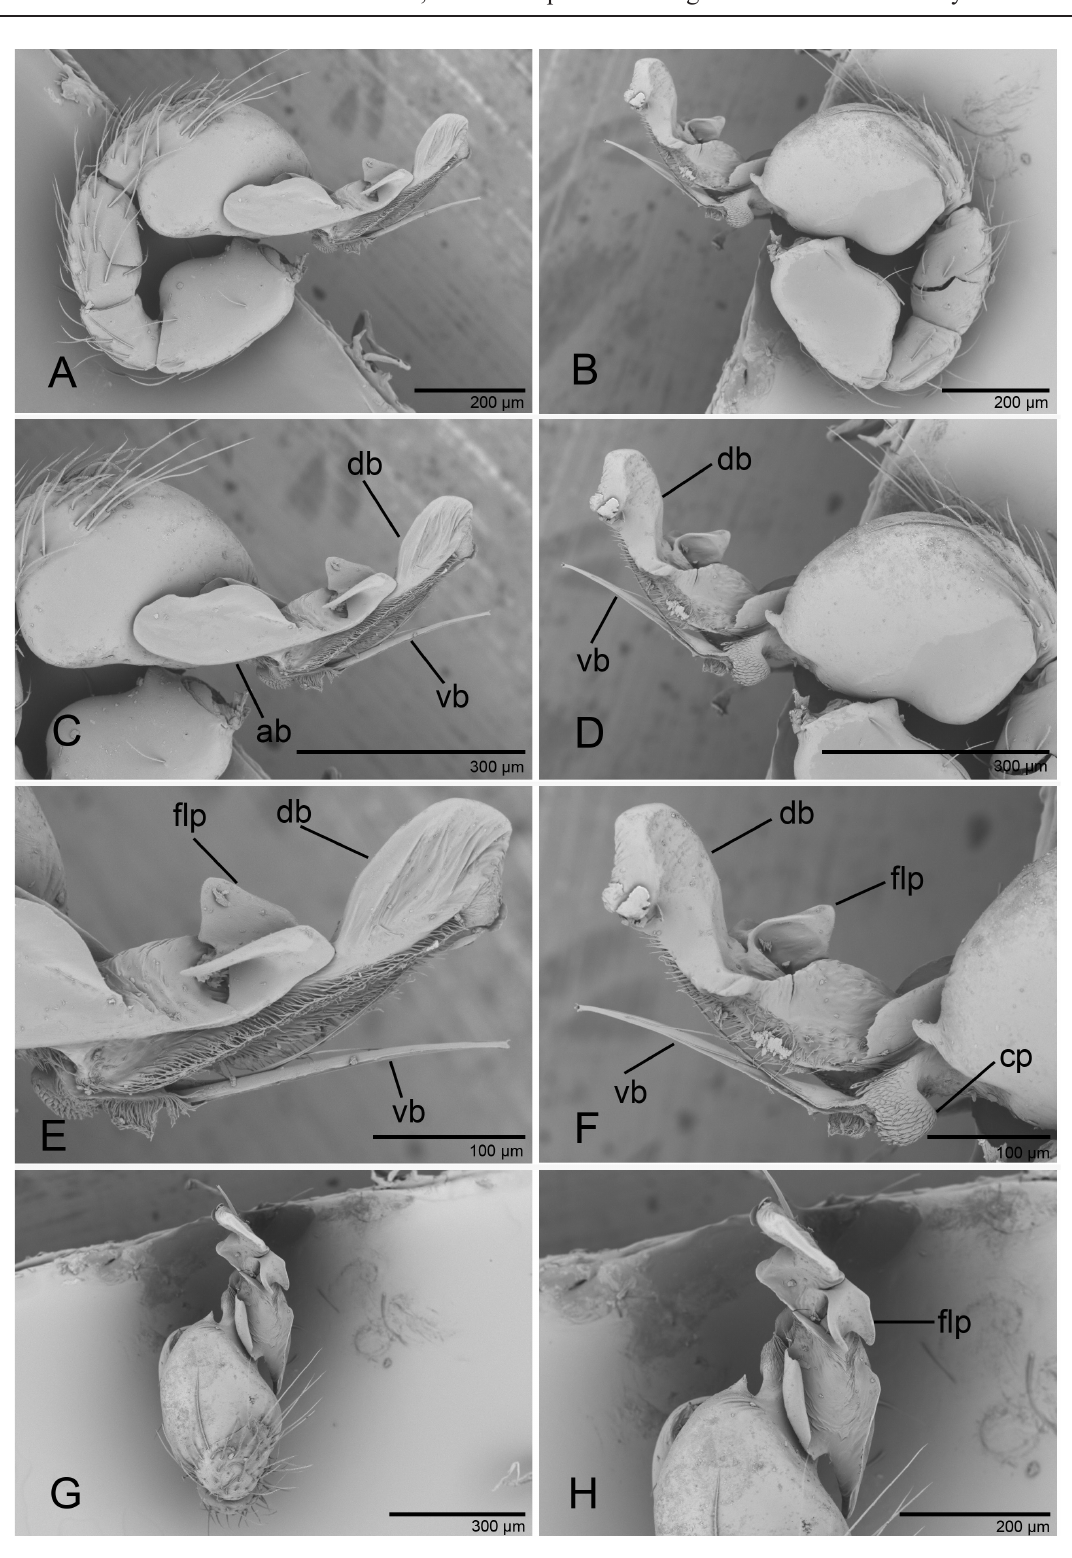
Fig. 2. Trilacuna jinyun Tong, Zhang & Li sp. nov., left male palp, SEM, holotype, ♂ (SYNU-291). A – B , G . Prolateral, retrolateral, and dorsal views. C – D . Palpal bulb in prolateral and retrolateral views. E – F , H . Distal part of palpal bulb in prolateral, retrolateral, and dorsal views. Abbreviations: ab = anterior branch; cp = circular projection; db = dorsal branch; flp = flag like protrusion; vb = ventral